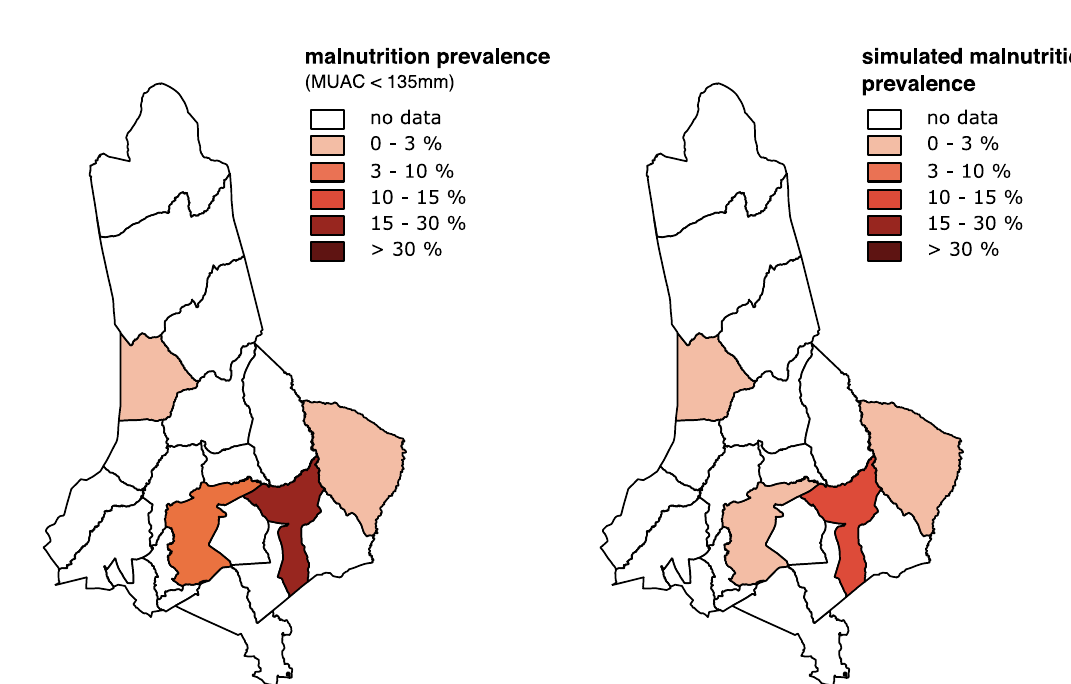
Fig. 3 Observed vs. simulated malnutrition prevalence in West Pokot (2017 – 18). The left panel depicts observed malnutrition prevalence; the right panel depicts simulated malnutrition prevalence. Prevalence is measured using the MUAC measure, and is displayed at the